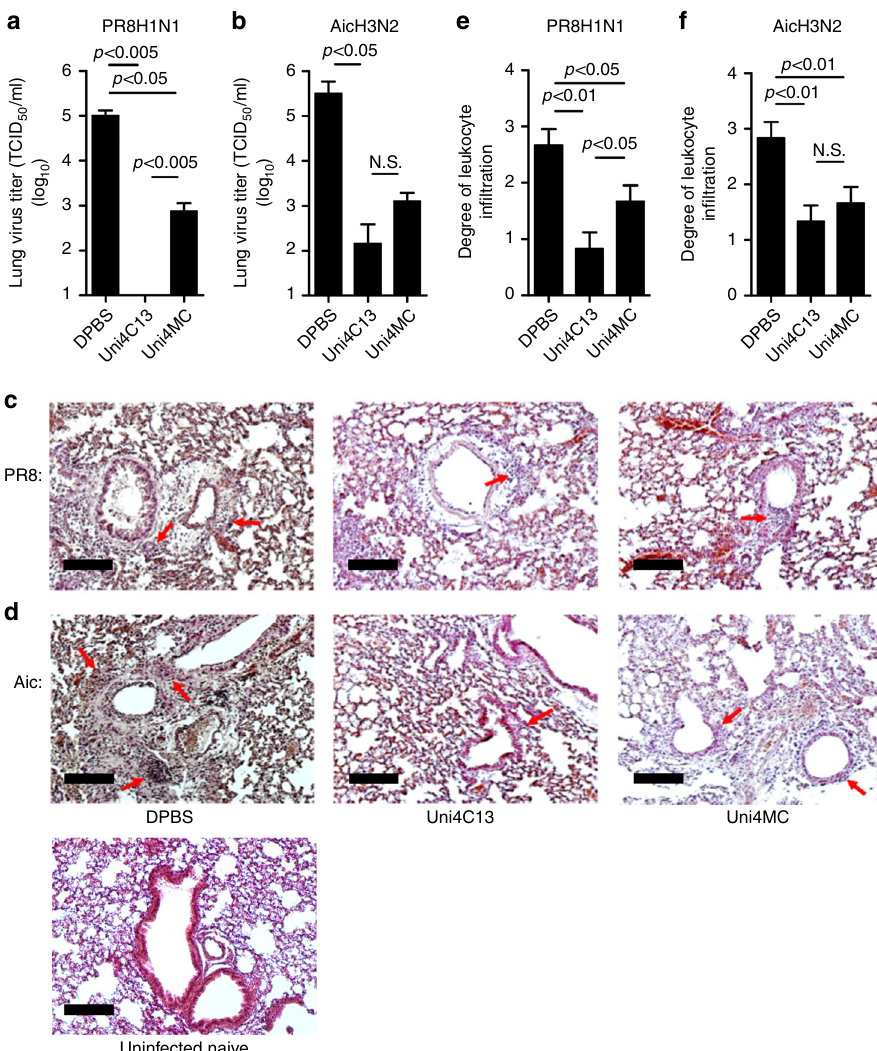
Fig. 5 Lung physiology in virus challenge infection. a , b Determination of mouse lung virus titers at day 5 post a sublethal dose infection with PR8 H1N1 ( a ) or Aic H3N2 ( b ). c , d Histological pathology analysis. Red arrows in images indicate leukocyte in fi ltration in lung sections from mice infected with PR8 H1N1 ( c ) or Aic H3N2 ( d ). Uninfected lung section is used as negative control. (Bars represent 400 µ m in length) e , f Bar charts showing the scores of leukocyte in fi ltrations degree after infection with PR8 H1N1 ( e ) or Aic H3N2 ( f ). Data are presented as mean ± SD ( n = 5) and statistical signi fi cance was analyzed by t-test for a , b , e and f . P values shown in bar charts and N.S. indicates no signi fi cance between two compared groups. The experiments were repeated twice with similar results. Images from c and d are representatives from fi ve individual mouse lung sections each